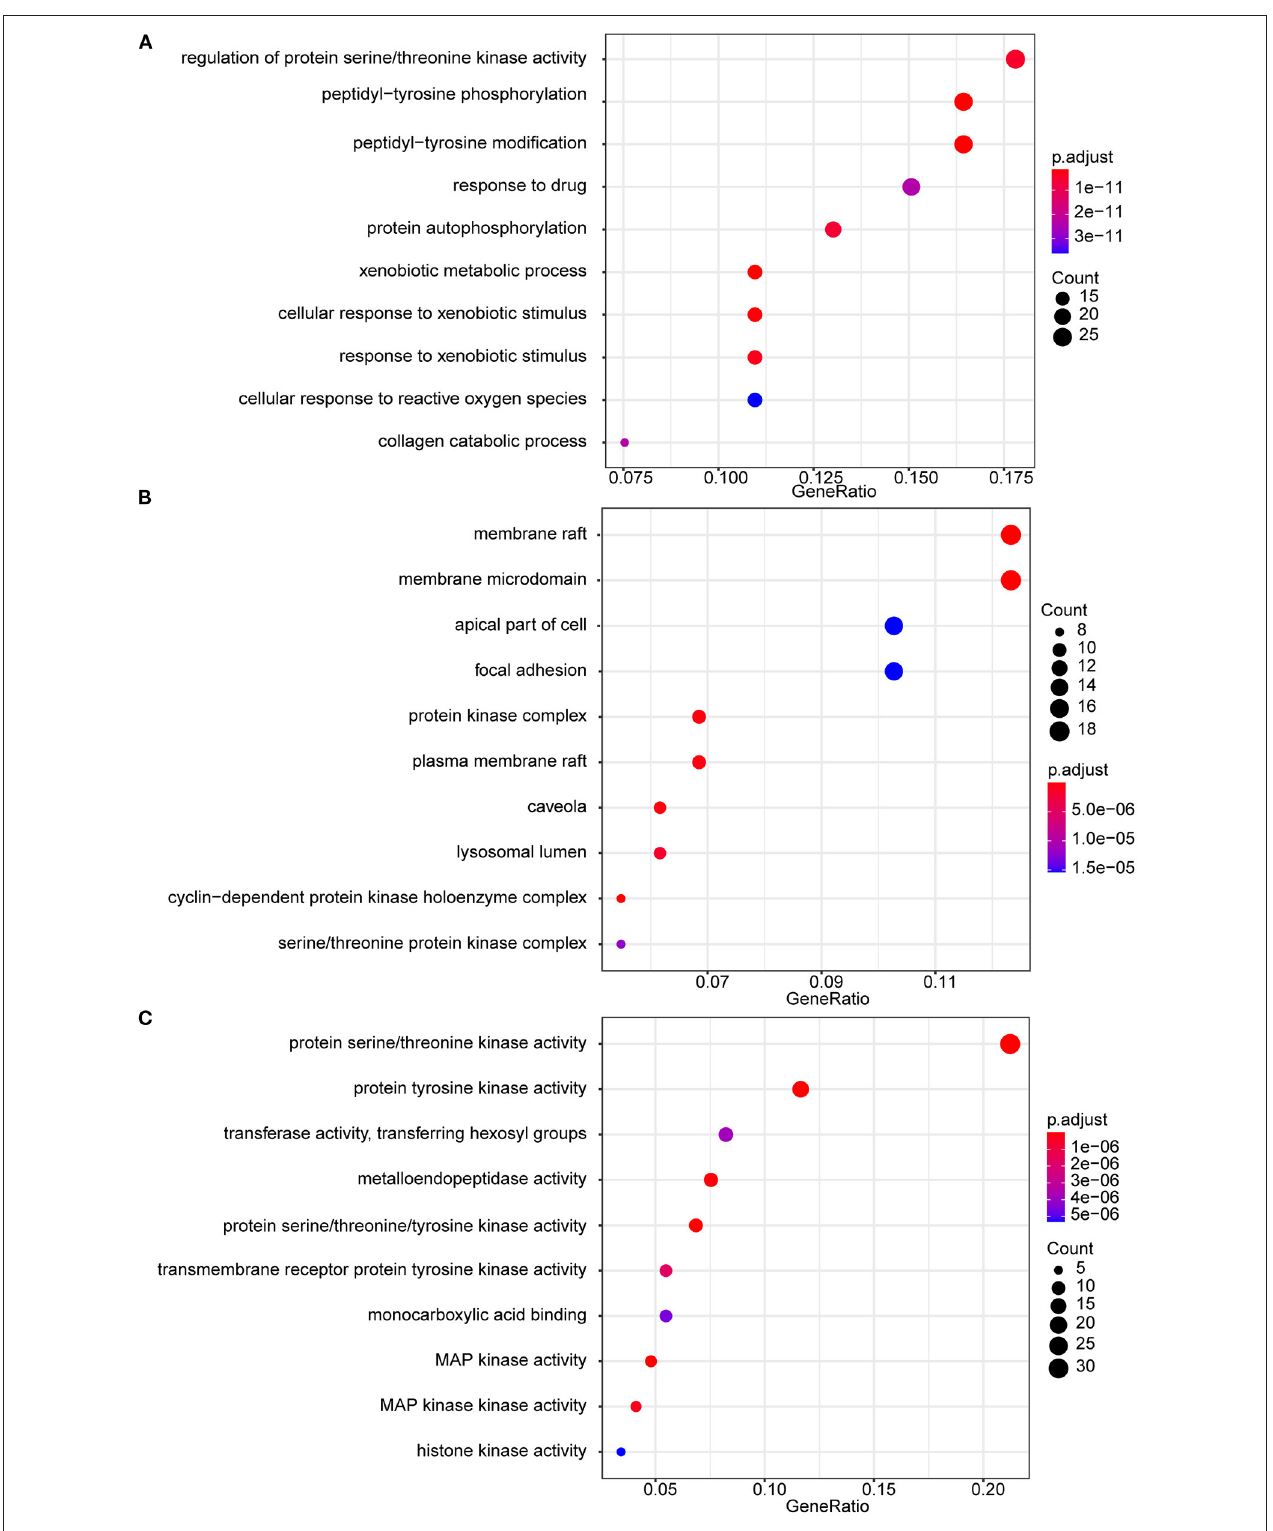
FIGURE 3 | GO enrichment analysis. (A) GO biological processes of 146 core genes; (B) GO cellular component of 146 core genes; (C) GO molecular function f 146 core genes.